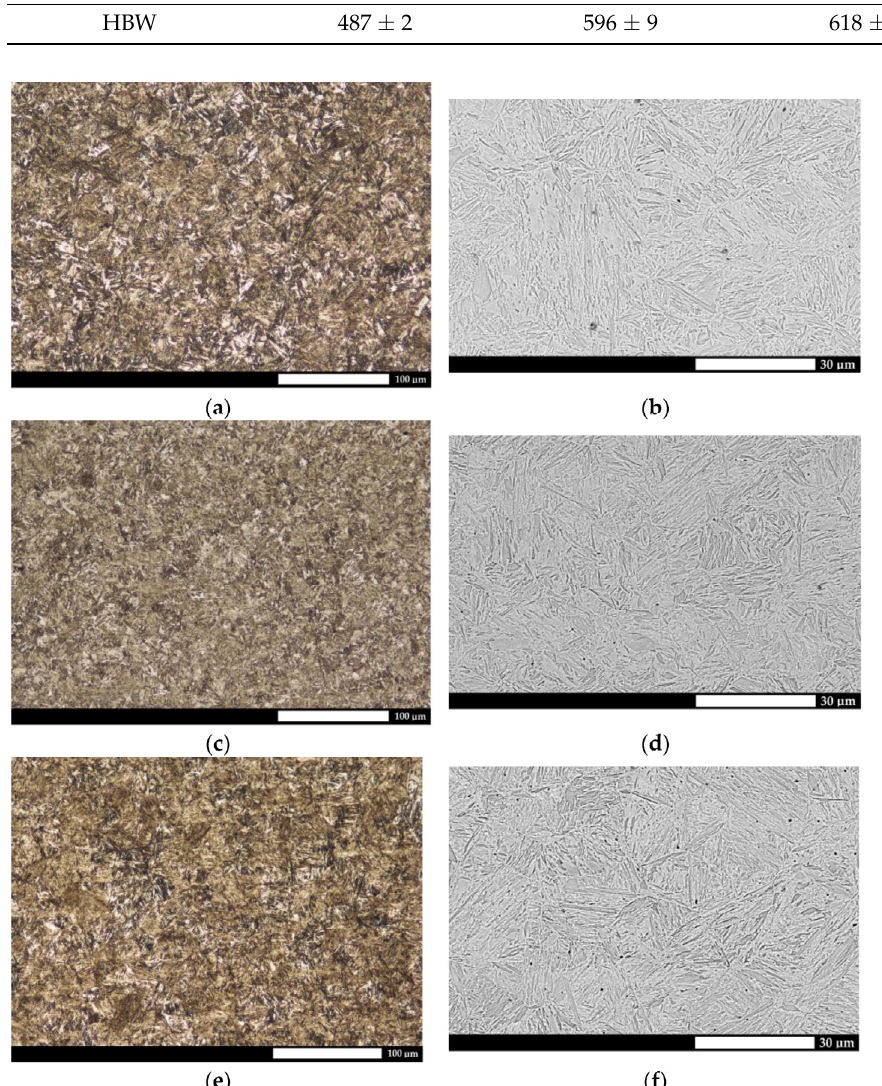
Figure 2. Microstructures of the analyzed abrasion-resistant steels. ( a , b ) Hardox 500, ( c , d ) Hardox 600, ( e , f ) Hardox Extreme. Light and electron microscopy. Etched with Mi1Fe (Nital). Additional assessment was ensured by the analysis of the former austenite grain size.